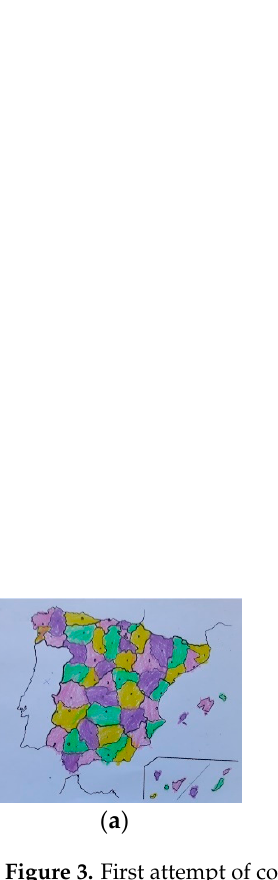
Figure 5. Example of Eulerian cycle. Drawing made by participant: ( a ) A2; ( b ) A3; ( c ) A5; ( d ) A7. We can observe several strategies to draw the cycle. Some participants labeled the vertices (A3, A4, A5 and A7); they go from left to right, going up and down; going from exterior regions to interior regions (A4 and A5). The cycle made by participant A2 is the only one that follows an ordered pattern with no crossing edges (planar graph). All par- ticipants looked for patterns as a problem-solving strategy. 3.2. Star Polygons Using a template with regular polygons of 4, 5, 9, 17 and 37 edges, we ask participants to draw star polygons by jumping a certain number of vertices without lifting the pencil from the paper. They choose jumps randomly, even larger than the number of vertices of the polygon. Figure 6 shows several examples. Participants A1, A2 and A3 only work with a pentagon and enneagon. All participants draw the star polygon 5/2 inside the pentagon, but only A1, A2, A3 and A7 find 9/2 and 9/4 inside the enneagon. ( a ) ( b ) Figure 6. Star polygons. Drawing made by participant: ( a ) A2 (similar to the one made by A1); ( b ) A3. In the case of 17 and 37 edges, participants A4, A5, A6 and A7 obtain some star pol- ygons, the findings of A6 and A7 being more elaborated, as shown in Figure 7.